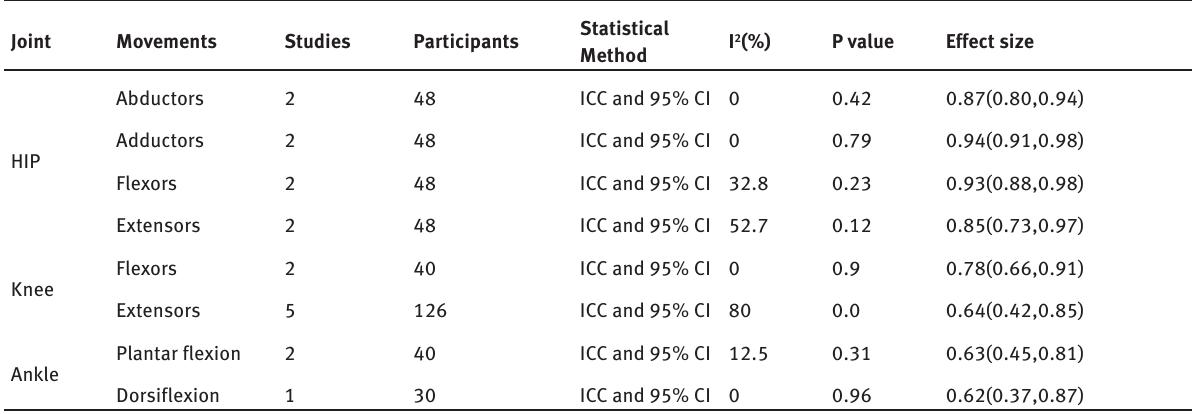
Table 9: Concurrent validity measured by ICC between HHD and isokinetic